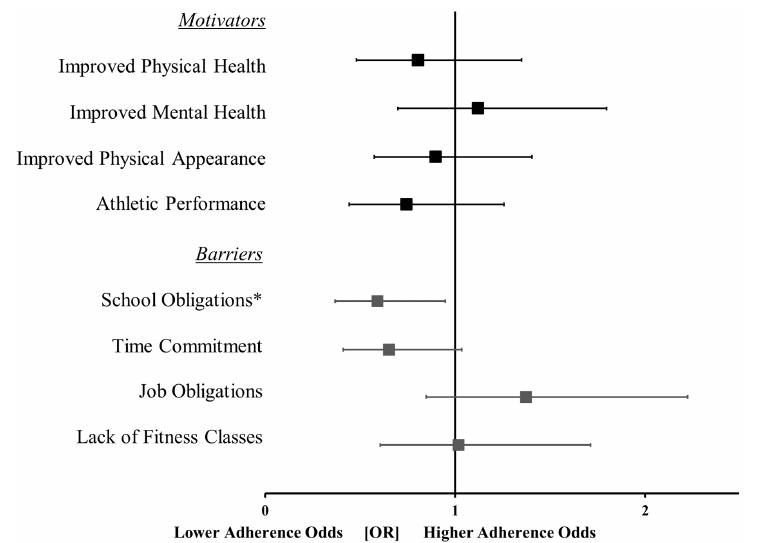
Figure 2. Forest plot displaying the odds ratios (OR) ± 95% confidence intervals for the motivators and barriers to achieving sedentary time guidelines. *, indicates a significance of p < 0.05. Note: Due to odds ratios having a minimum value of 0 (i.e., cannot be less than 0) and an infinite maximum value, the 95% confidence intervals were asymmetrical in magnitude.